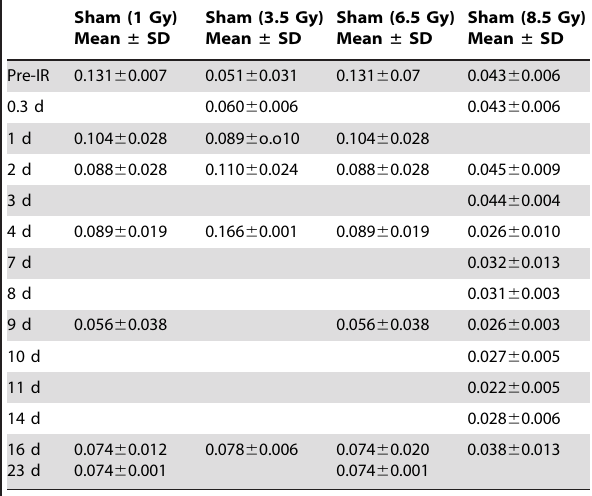
Blanks indicate no data for the corresponding times and doses. Pre-IR: values for c -H2AX foci per cell prior to irradiation. Asterisks denote statistically difference between TBI-and sham-irradiated macaques ((*): P , 0.05, (**): P , 0.01, (***): P , 0.001;